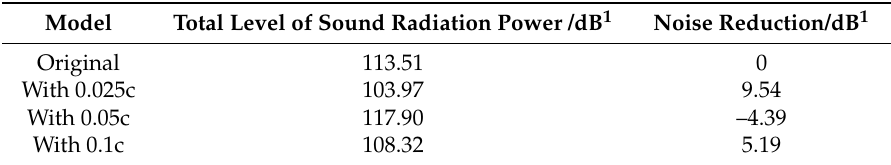
Table 2. The total level of sound radiation power from the model with leading-edge serrations of different amplitudes.